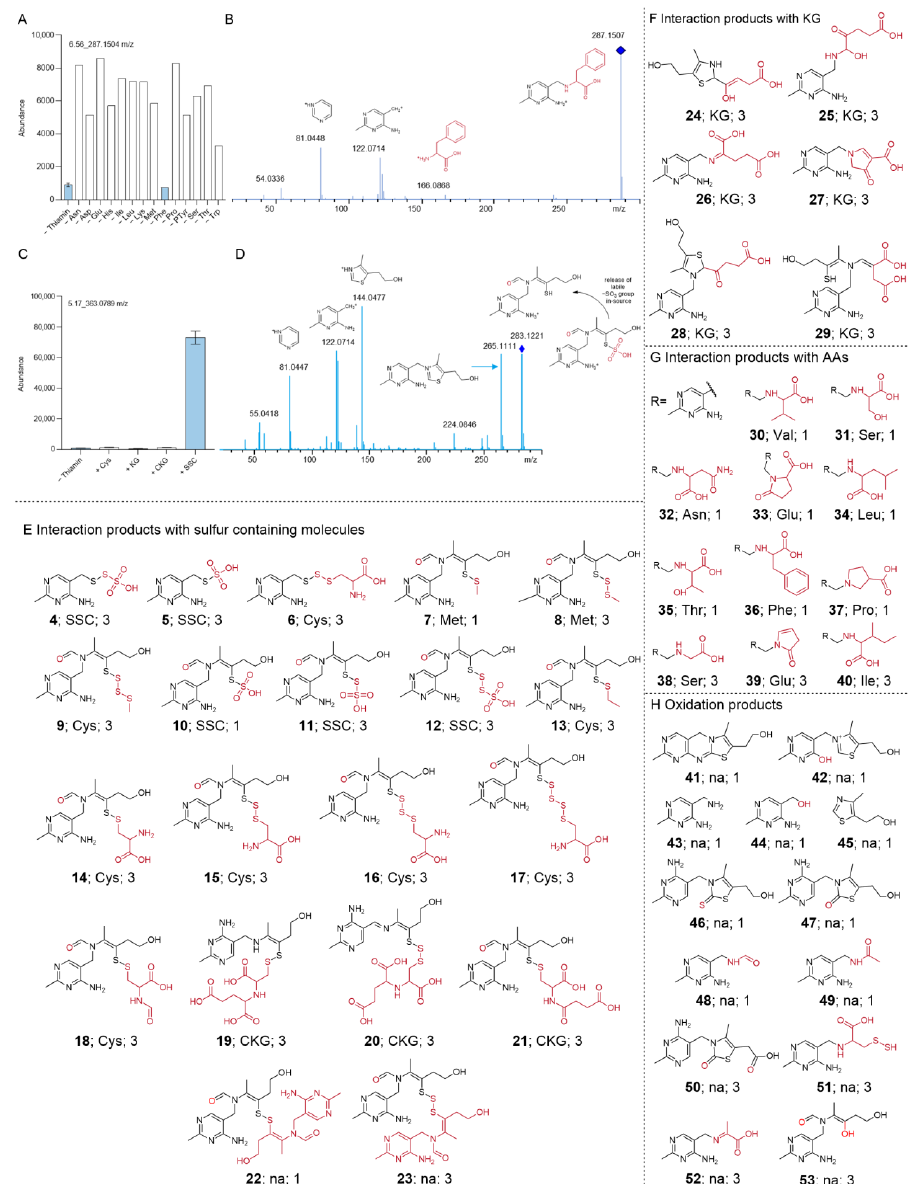
Figure 2. Strategies used to investigate thiamin instability and formed degradation/interaction products. ( A ) Example for identification of thiamin interaction partner via compound-deficient feeds, e.g., identification of Phe as the respective interaction partner of thiamin for 6.56_287.1504 m / z since the feature was not generated in thiamin- and Phe-deficient conditions. ( B ) Example